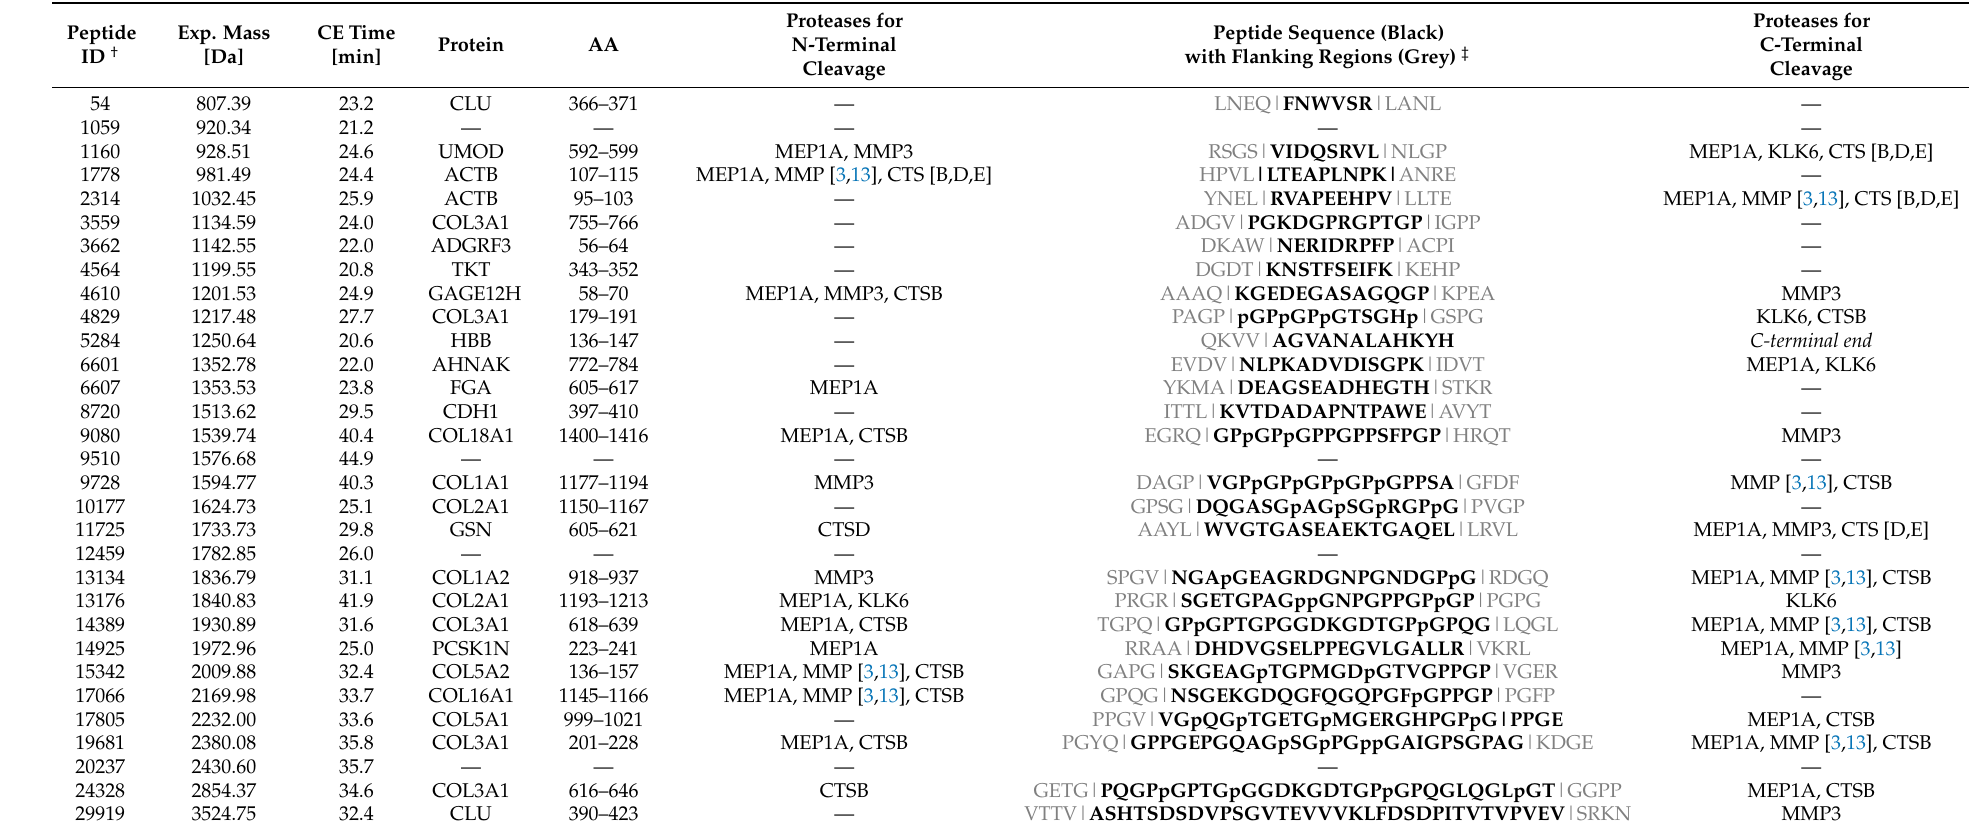
Table 3. Characterization of the 31 urinary HCC peptide markers by amino acid sequencing and in silico protease prediction analysis together with their experimental spectrometry mass, retention time in capillary electrophoresis, and location in the proteins linear